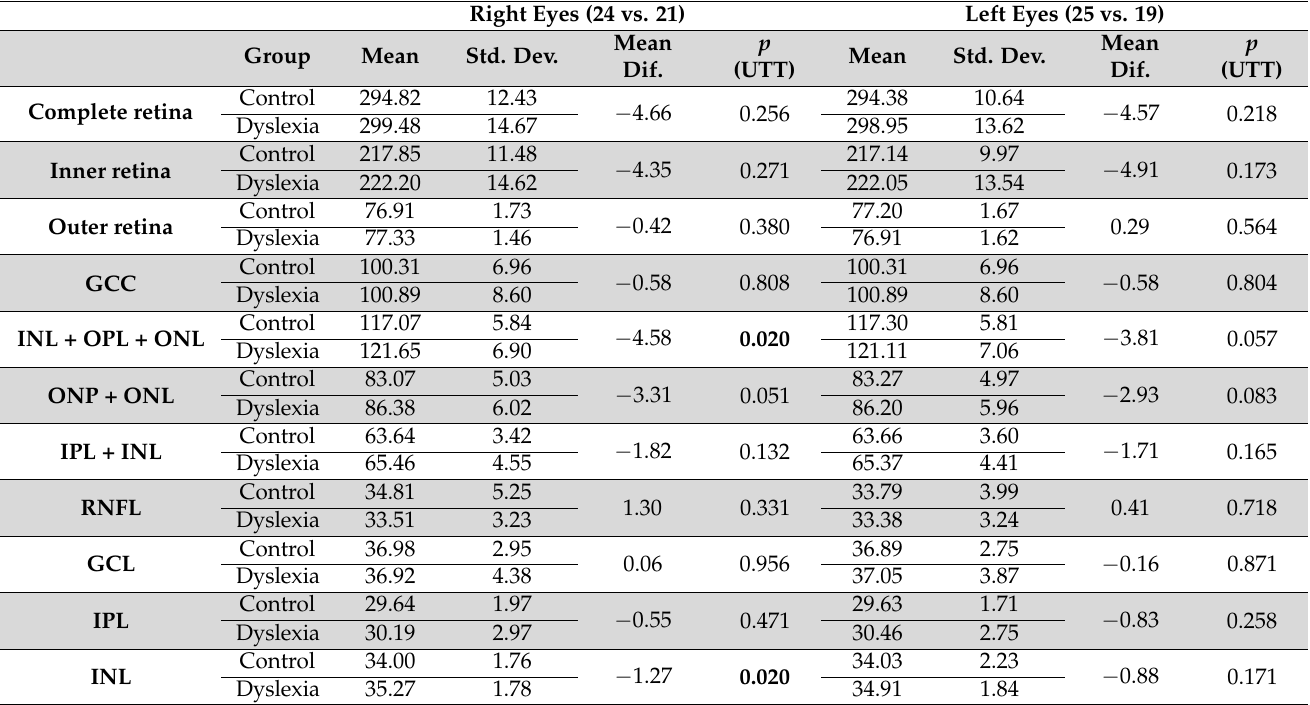
Table 2. Thickness comparison between the groups for the outer ring subfield (perifovea) in the ETDRS grid. Thickness of the Outer ETDRS Ring Subfield (Perifovea) Comparisons between Normal Controls and Dyslexic Subjects Right Eyes (24 vs. 21) Left Eyes (25 vs. 19) Group Mean Std. Dev.